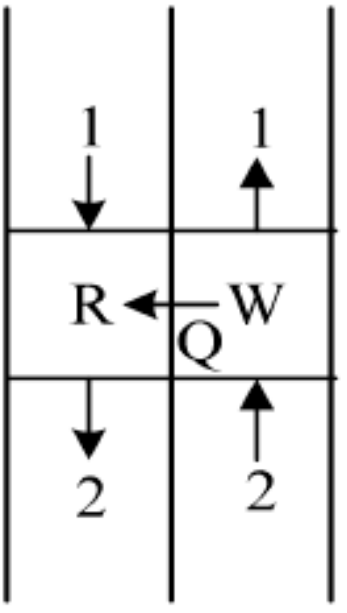
Figure 3. Schematic diagram of calculation micro-element